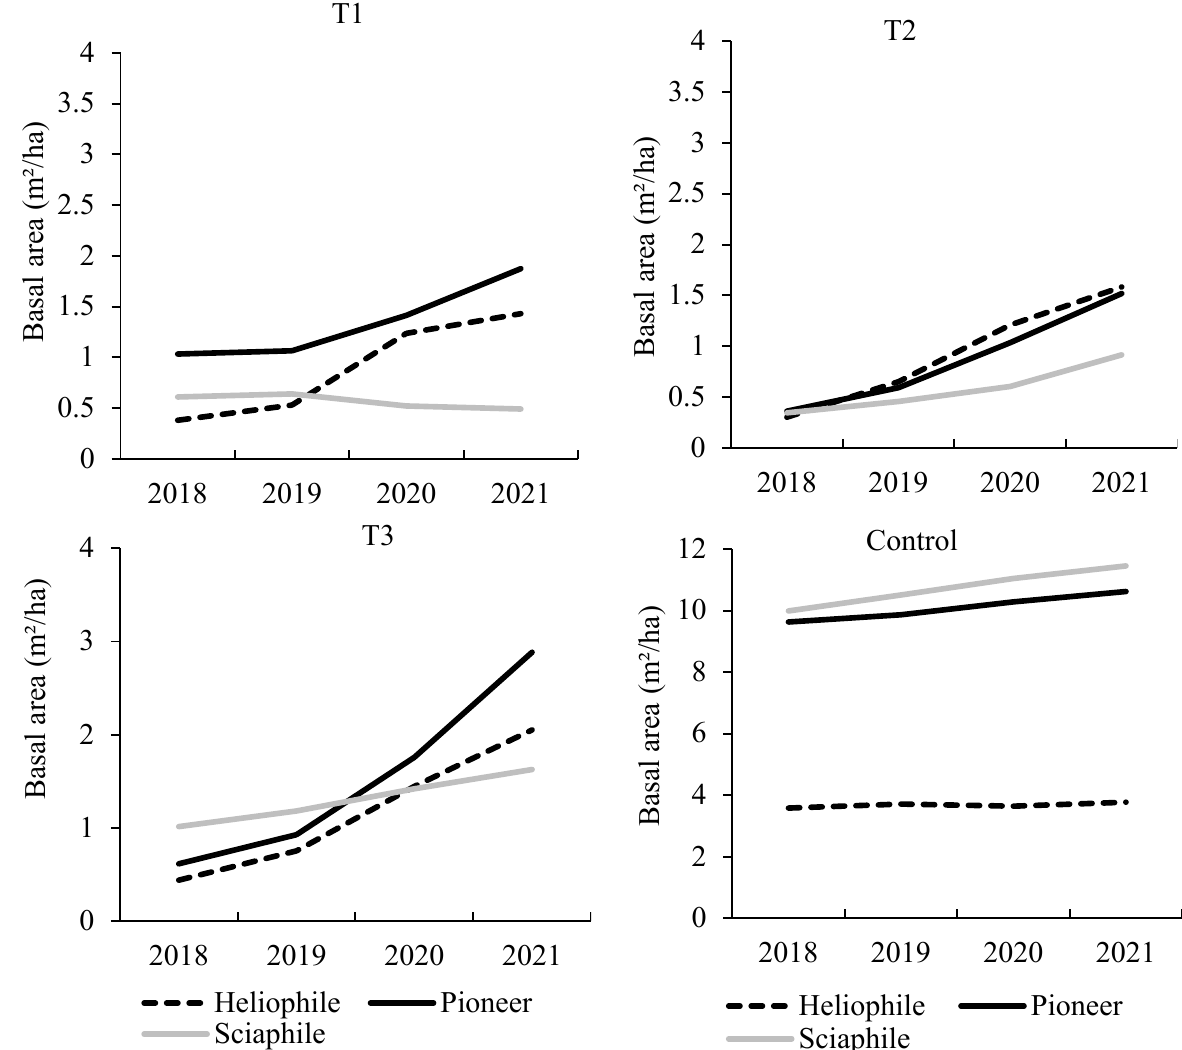
Figure 4. Change in the average basal area of the trees by treatment. T1 = cocoa plantations which were regularly maintained and exploited, T2 = cocoa plantations which were not maintained but exploited, T3 = cocoa plantations without activities, and Control = a forest relic.